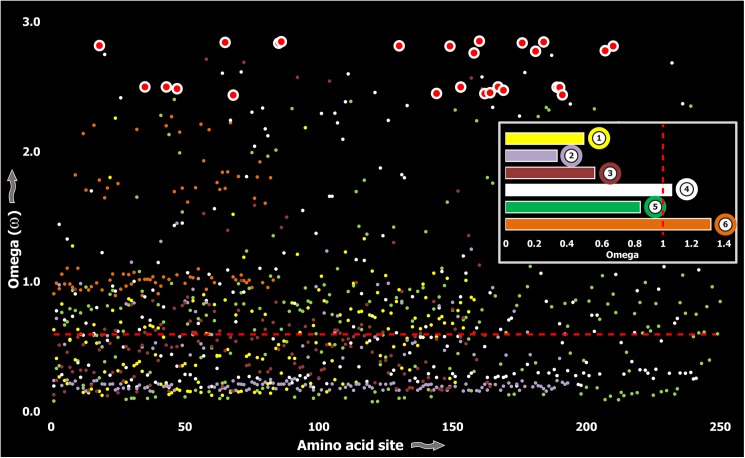
Molecular evolution of venom in Toxicofera lizards.A plot of site-specific ω against amino acid positions for various Toxicofera lizard toxin types is presented. The red horizontal line represents the line of neutrality: points above and below this line indicate positive and negative selection, respectively. Bar plot color codes: 1) Phospholipase A2; 2) Nerve Growth Factors; 3) Natriuretic peptides and 4) CRiSPs; 5) Kallikreins; and 6) crotamines.